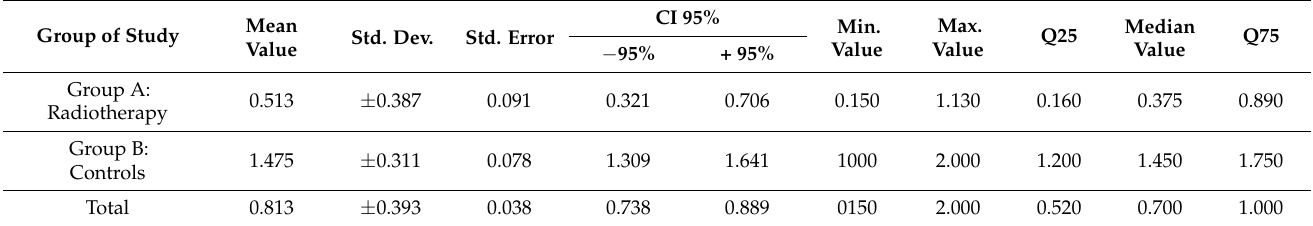
Table 5. The central tendency indicators of stimulated salivary flow (SSF).